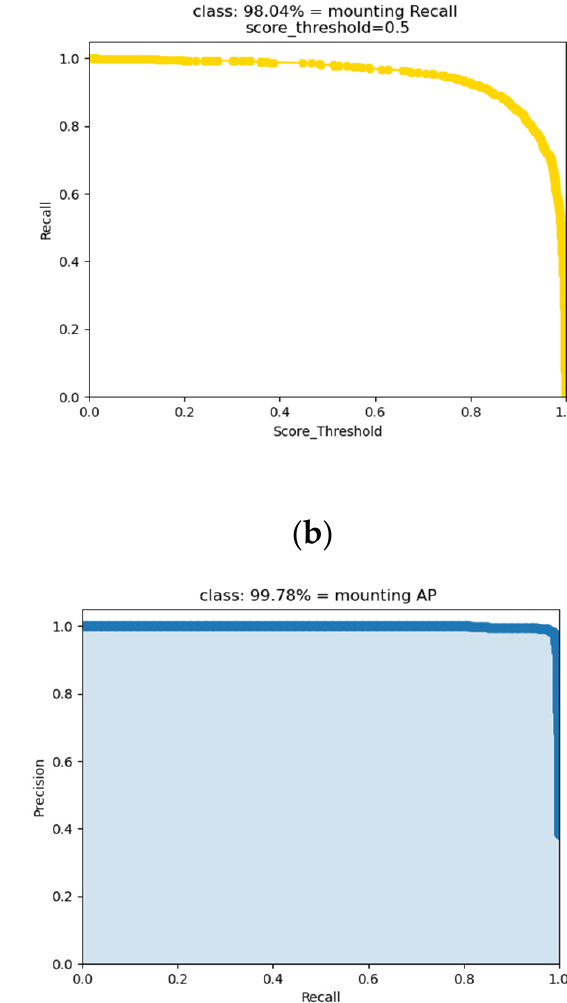
Table 2. Comparison of evaluation indexes of this model and other models.